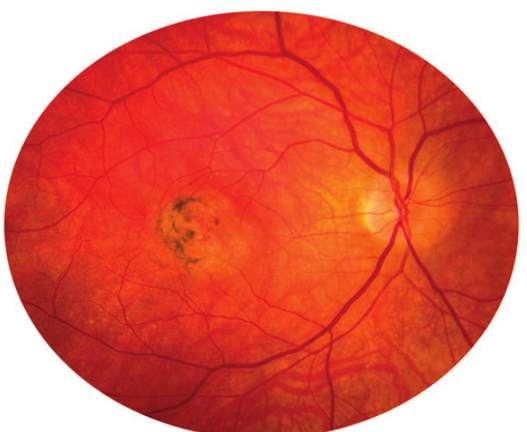
Figure 3. Sorsby fundus